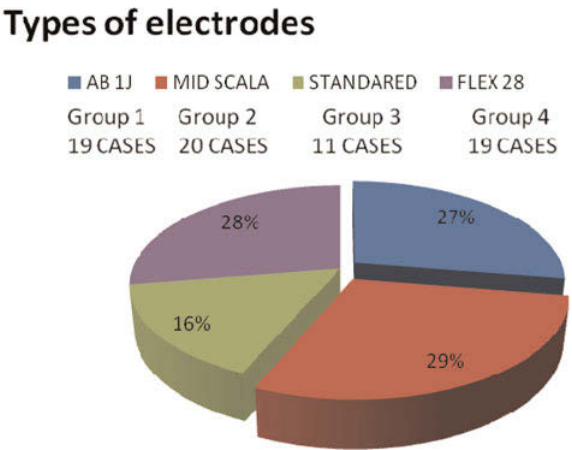
Distribution of the number of patients by category of electrode.